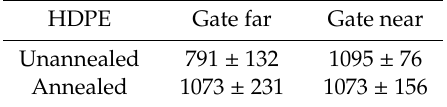
Table 5. Complex moduli (MPa) of unannealed and annealed HDPE for gate far and gate near.